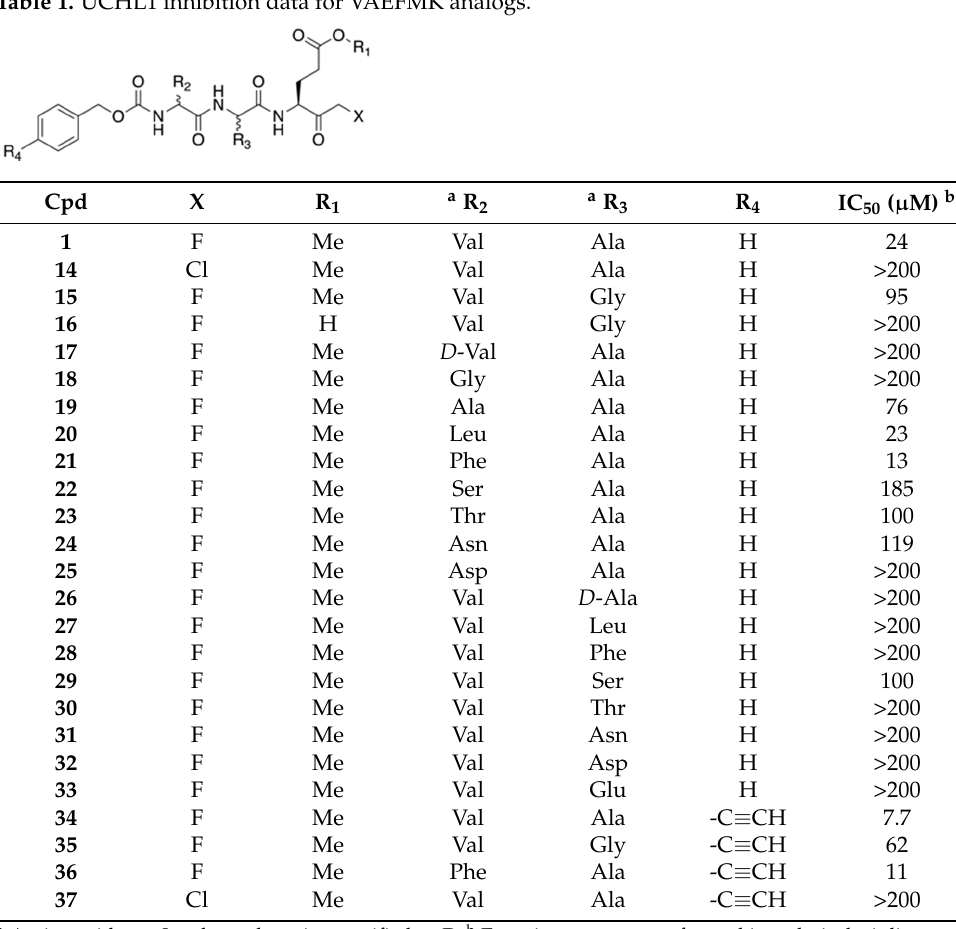
Figure 2. Time-dependent inhibition of UCHL1 by 1 . IC 50 curves for His-UCHL1 treated with 1 at various points in time shows increasing potency with increasing length of incubation. Table 1. UCHL1 inhibition data for VAEFMK Table 1. UCHL1 inhibition data for VAEFMK analogs.